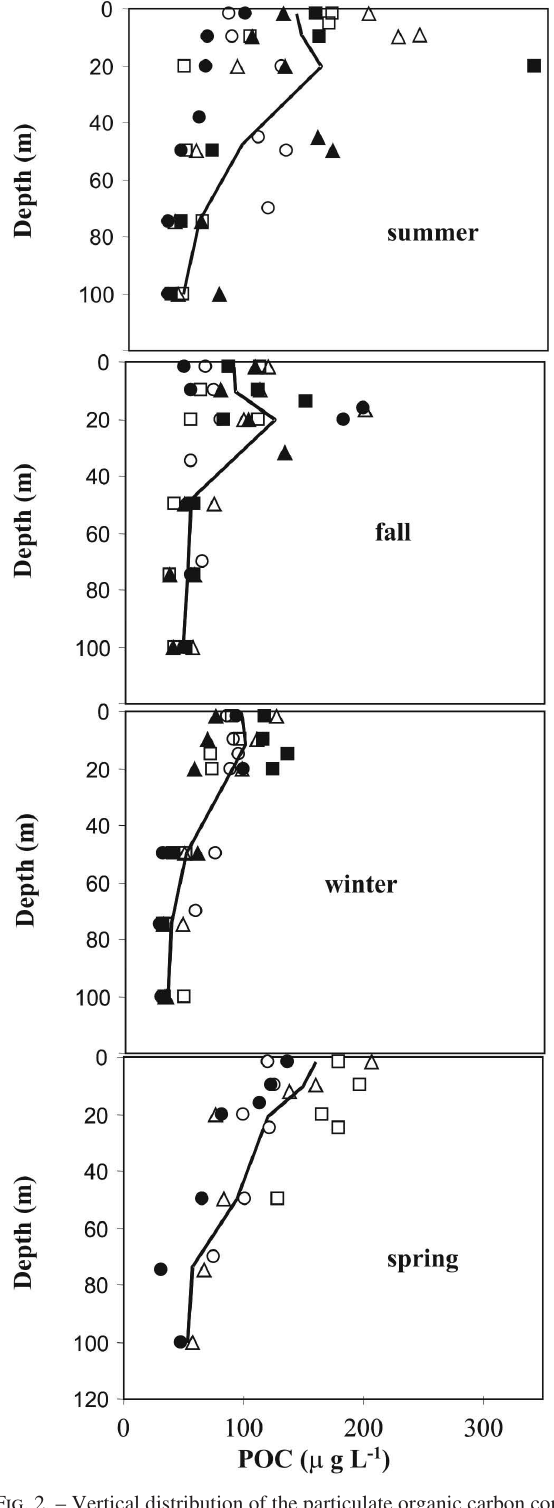
Fig . 2. – Vertical distribution of the particulate organic carbon con- centration (POC, m g L -1 ) obtained at the sampling stations during the four seasonal surveys (station 1: open circles; station 2: open squares; station 3: open triangles; station 4: closed circles; station 5: closed squares; station 6: closed triangles). The solid lines represent the averaged seasonal